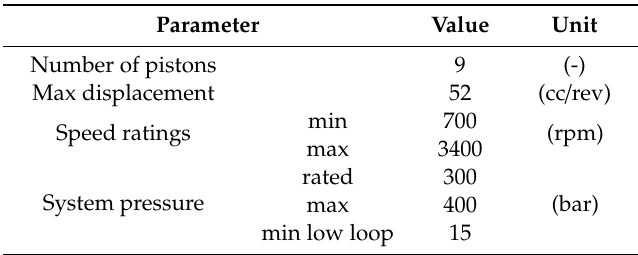
Table 1. Data of the reference